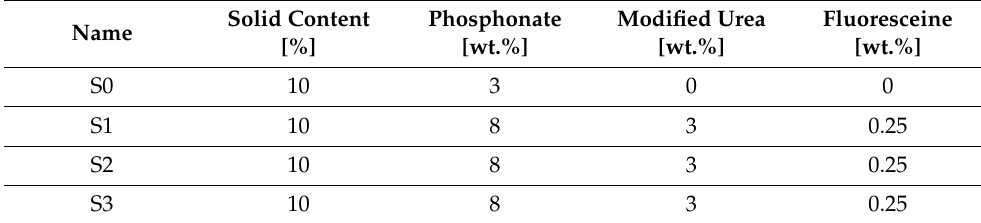
Table 1. Composition of suspensions used in the HVSFS coating